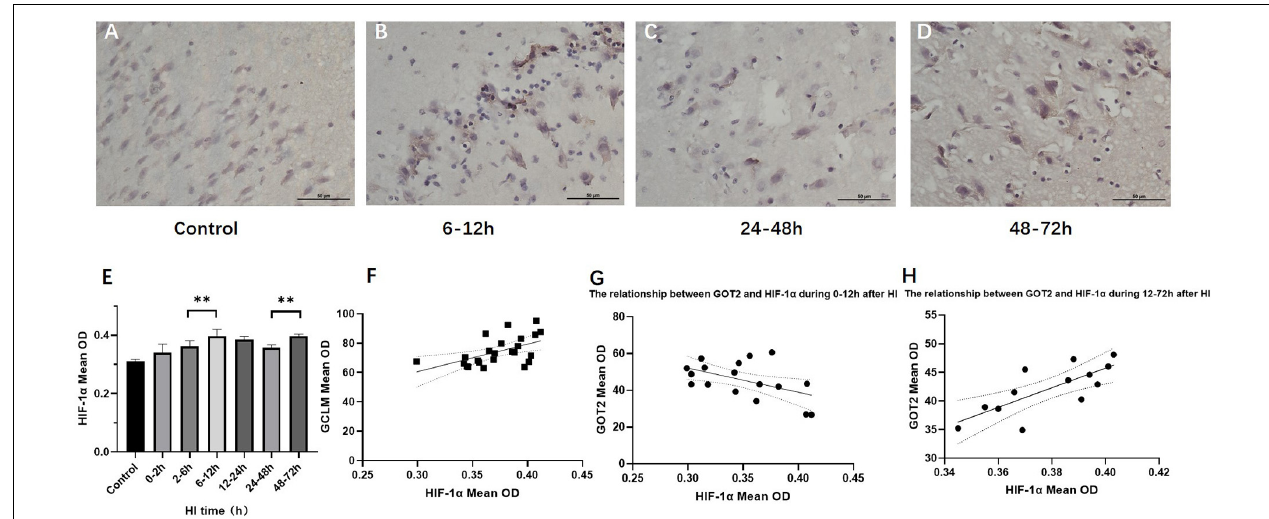
FIGURE 4 | Changes in HIF-1 α expression ( × 400) and scatter plot of correlation with GCLM and GOT2 after HI. (A–D) Immunohistochemical staining for HIF-1 α in the control group and HI groups at 6–12, 24–48, and 48–72 h after HI. (E) HIF-1 α expression level gradually increases after HI, reaching the first peak in the 6–12 h group, significantly decreases in the 24–48 h group, and increases again in the 48–72 h group. (F) Scatter plot of the correlation between HIF-1 α and GCLM expression. There is a significant positive correlation. (G,H) Scatter plot of the correlation between HIF-1 α and GOT2 expression. In the control group and HI groups